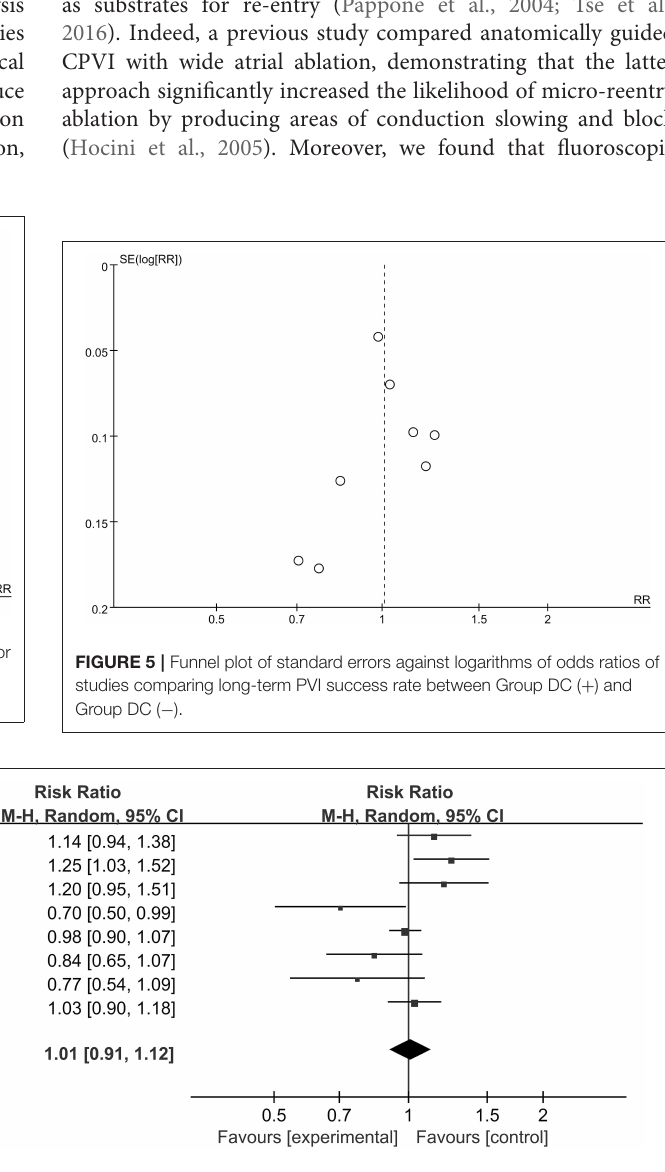
FIGURE 4 | Forest plot comparing long-term PVI success rate between Group DC ( + ) and Group DC ( − ).